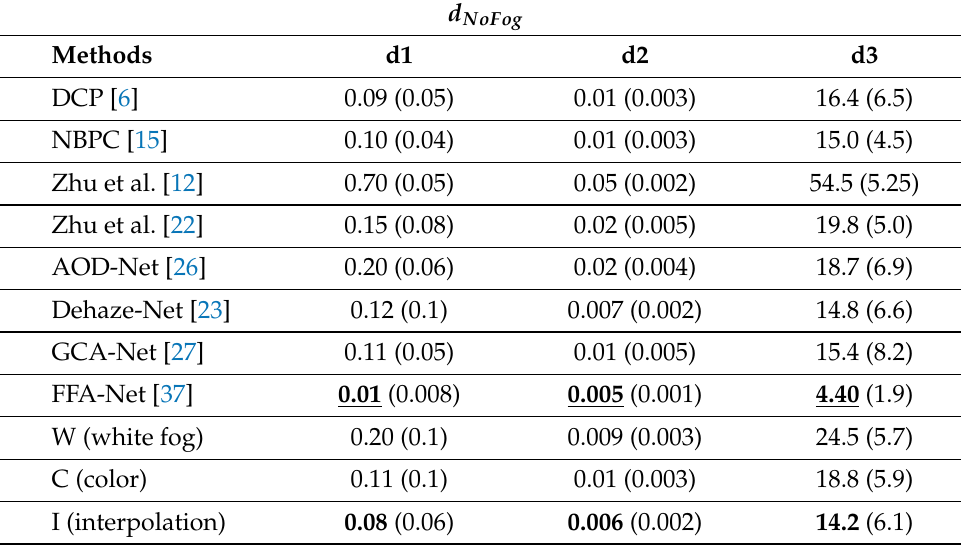
Table 6. Comparison of three distance indexes d1, d2, and d3 on fifty images from the SOTS dataset, with the d NoFog index (in the no-fog area). W corresponds to our main algorithm assuming white fog, C to the color version, and I to the interpolation version. The two best results are in bold. The best result is also